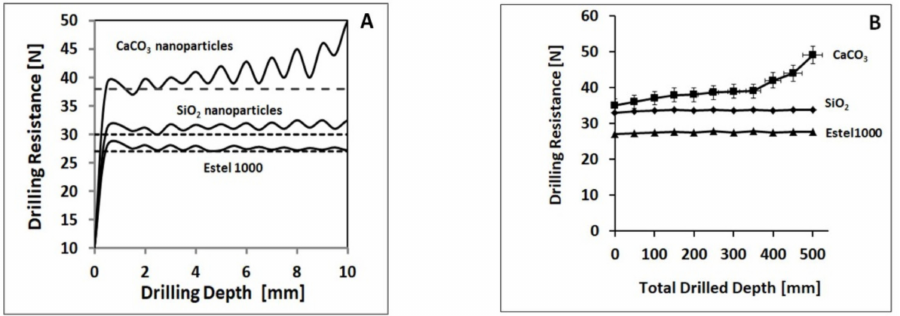
Figure 3. ( A ) Increasing wear effect by drilling successive holes in an abrasive material (Pietraforte sandstone), using a Diaber drill bit ∅ 5 mm at 600 rpm and 10 mm/min advancing rate (from Delgado Rodrigues and Costa 2004, [40]). ( B ) Differential abrasion increase in one Diaber drill bit ∅ 5 mm, measured on two materials having different initial drilling resistance values.